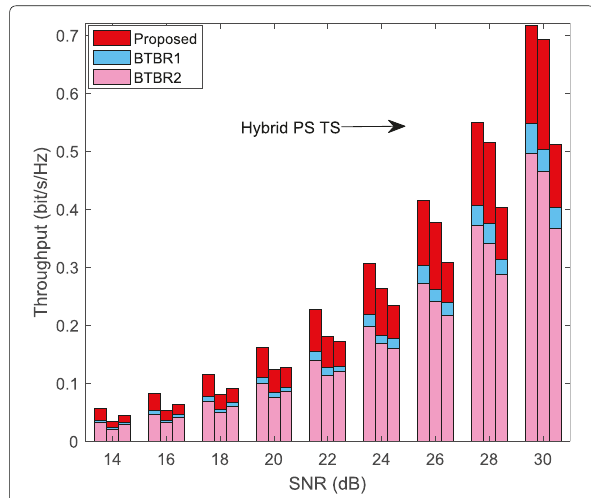
Fig. 7 Throughput performance of different protocols versus transmit SNR, d SR = 2 m, N =